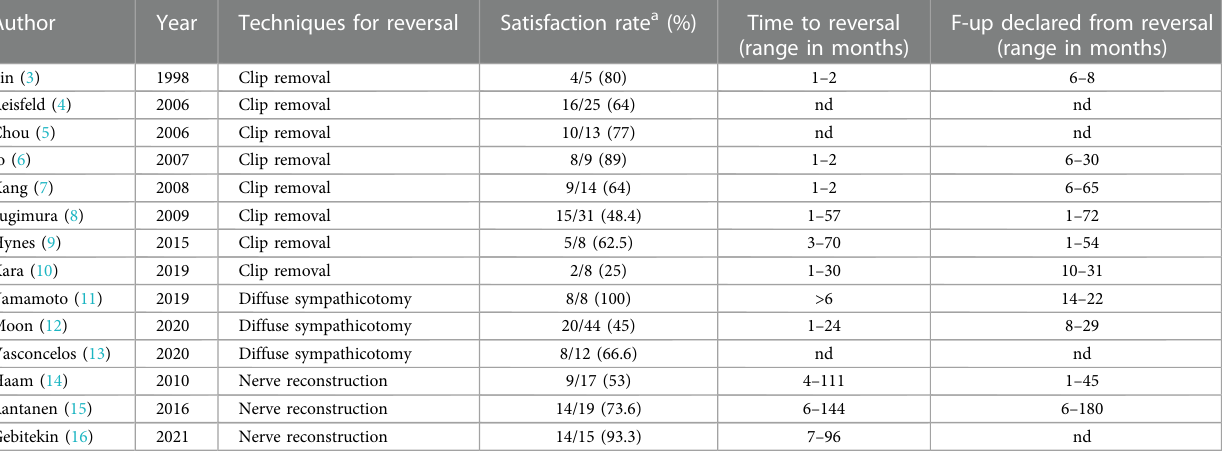
TABLE 2 Outcomes of reversal